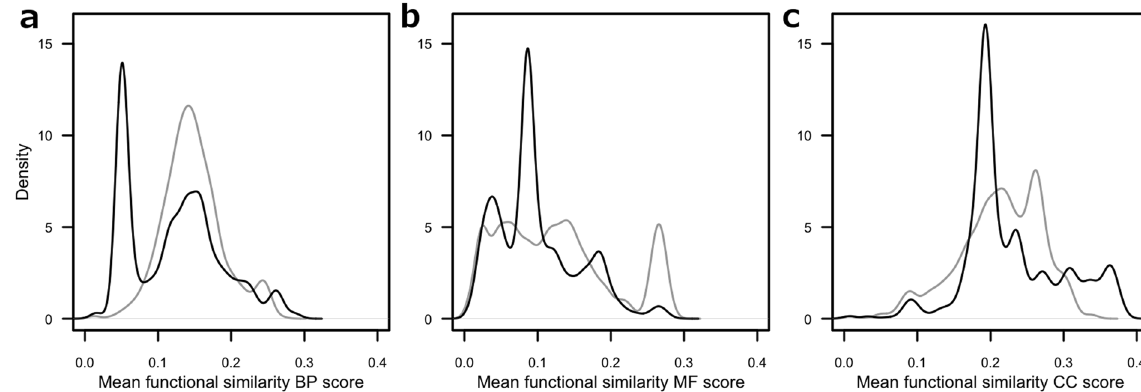
Figure 1. Average simLin / fsAvg score distributions for BP, MF, and CC ontologies for human/mouse protein pairs. For a human protein P , the score average is computed by forming pairs of proteins ( P , R ) over 1000 randomly selected mouse proteins R , with the kernel density estimates of the respective distributions being displayed for the IEA ( + ) dataset (black solid lines, density computed from 93806 annotated proteins, also see Table 1) and the IEA ( − ) dataset (grey lines, 21212 annotated proteins). ( a ) BP score distribution. Manually annotated protein pairs show a clear peak at a simLin / fsAvg score of 0.15. Including IEA evidence codes in the annotation corpus generates a second peak very close to 0.0. A large portion of this peak can be attributed to the roughly 70000 human gene products, which are exclusively annotated with IEA evidence codes. ( b ) MF based score distribution. Unlike BP with its sharp peak for the manual annotations, this ontology is characterized by a more uniform distribution of scores, with a notable peak near 0.27, generated by approximately 1600 proteins. GO enrichment analysis of these proteins shows that they are significantly enriched in “protein binding” (GO:0005155, p < 10 − 100 ), suggesting that gene products annotated to this term generally yield much higher than average simLin / fsAvg MF scores. ( c ) CC score distribution. Here, both manual and electronic annotation peaks are closer to each other than in the other two ontologies. Furthermore, electronic annotations are characterized by densities in the upper score range ( > 0.3), where the manual annotation scores have already tailed